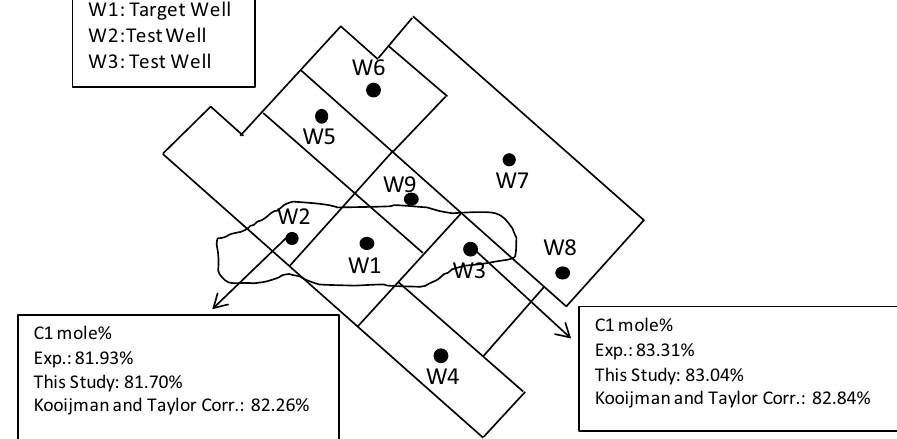
Fig. 5 Validation of model with experimental